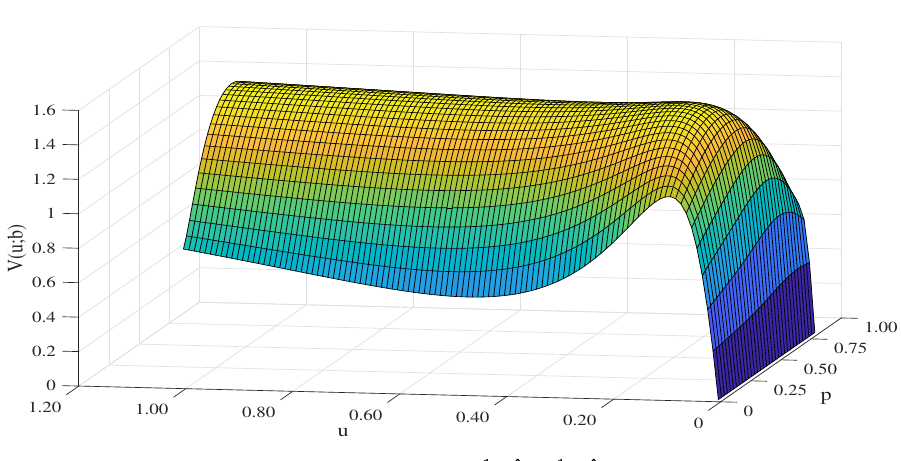
Figure 4. Images of V ( u ;0.5 ) when N = 10, ˆ α = 1